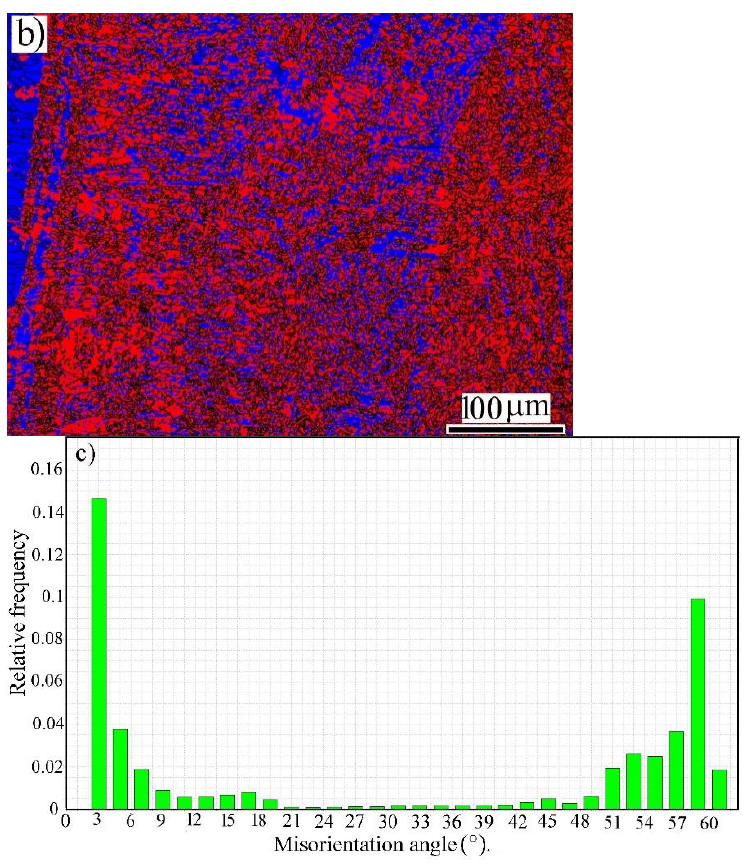
Figure 3. Close view of the FZ structure at EI 50 J/mm: ( a ) EBSD misorientation map (low-angle boundaries in green); ( b ) EBSD phase map with indexing α (cid:48) - bct in red and γ - fcc austenite in blue; ( c ) relative frequency of low- and high-angle grain boundaries corresponding to ( a ).